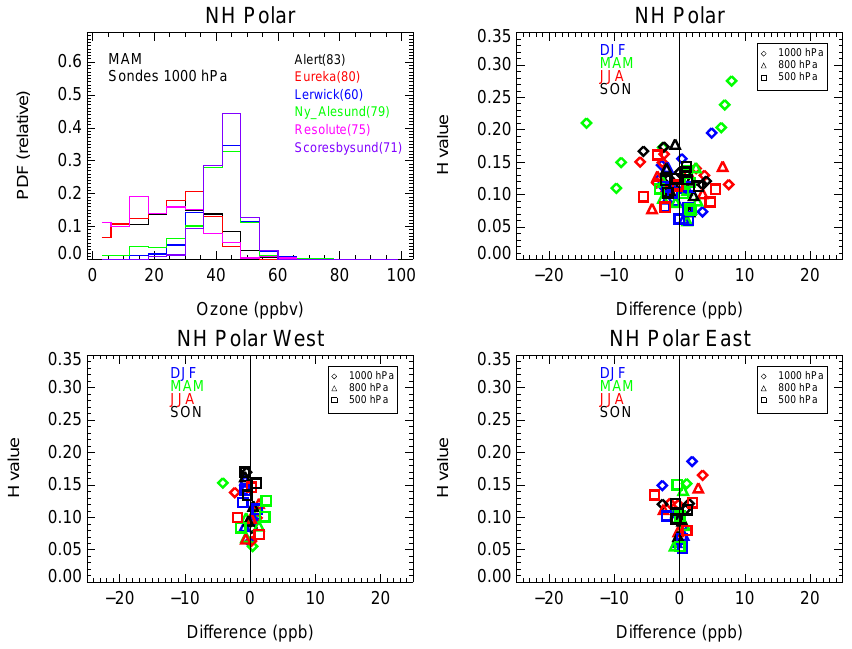
Fig. 5. Top, left panel: probability distribution function (PDF) of ozone at 1000hPa for different stations in high northern latitudes (different colors) for spring. Right top panel: Hellinger distance between the ozone distribution of single stations (shown on the left) and the regionally aggregated distribution versus the median differences of the two distributions. Different symbols indicate three altitude levels for 4 seasons (winter: blue, spring: green, summer: red, fall: black). Bottom panel: same as right top panel, but for NH Polar West (left) and NH Polar East